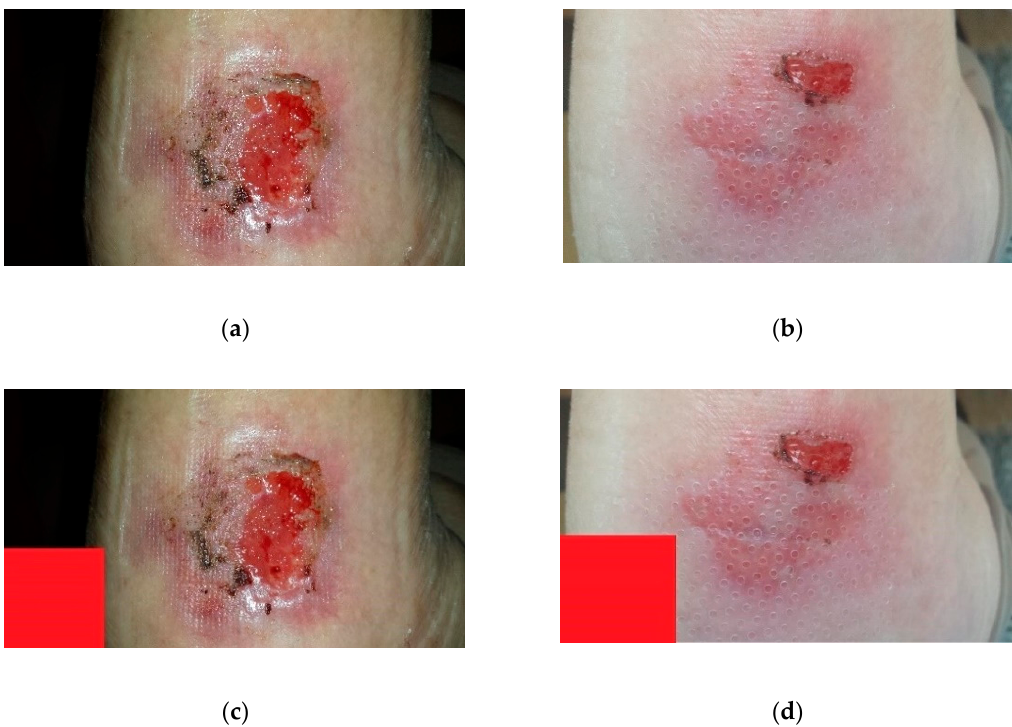
Figure 18. Photographs of the wounds: ( a ) initial picture; ( b ) current picture; ( c ) initial picture, modified; ( d ) current picture,